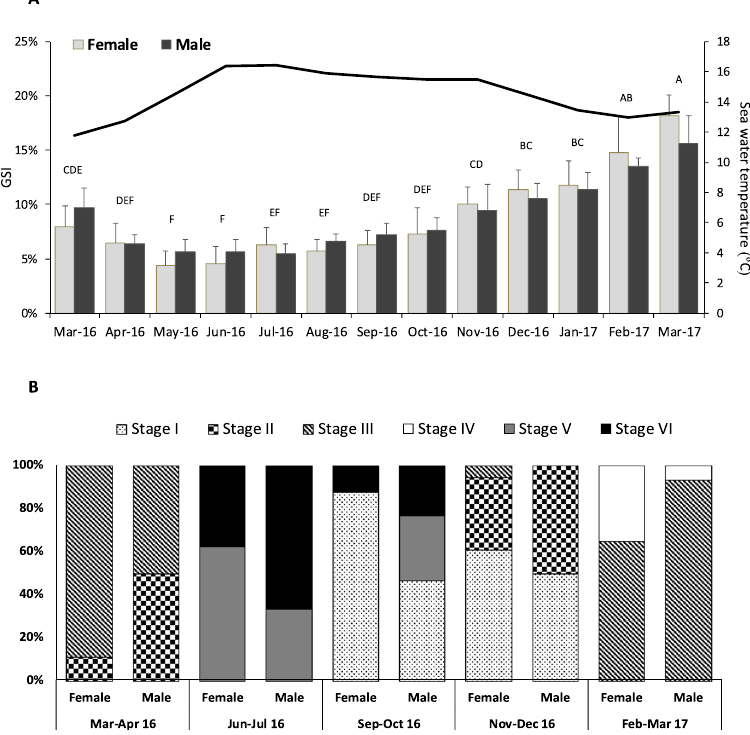
Figure 1. Annual reproductive cycle of females and males P . lividus in Praia Norte (Portugal); ( A ) variations in the gonad somatic index (GSI) over a 13-month period; ( B ) Gametogenic stages of ovary and testis through histological examination. Values are mean ± standard deviation; per month the 18 individuals were pooled by sex: N = 3 pools of female gonads and N = 3 pools of male gonads were established. Superscripts in capital letters ( ABC ) indicate significant differences between months (P <